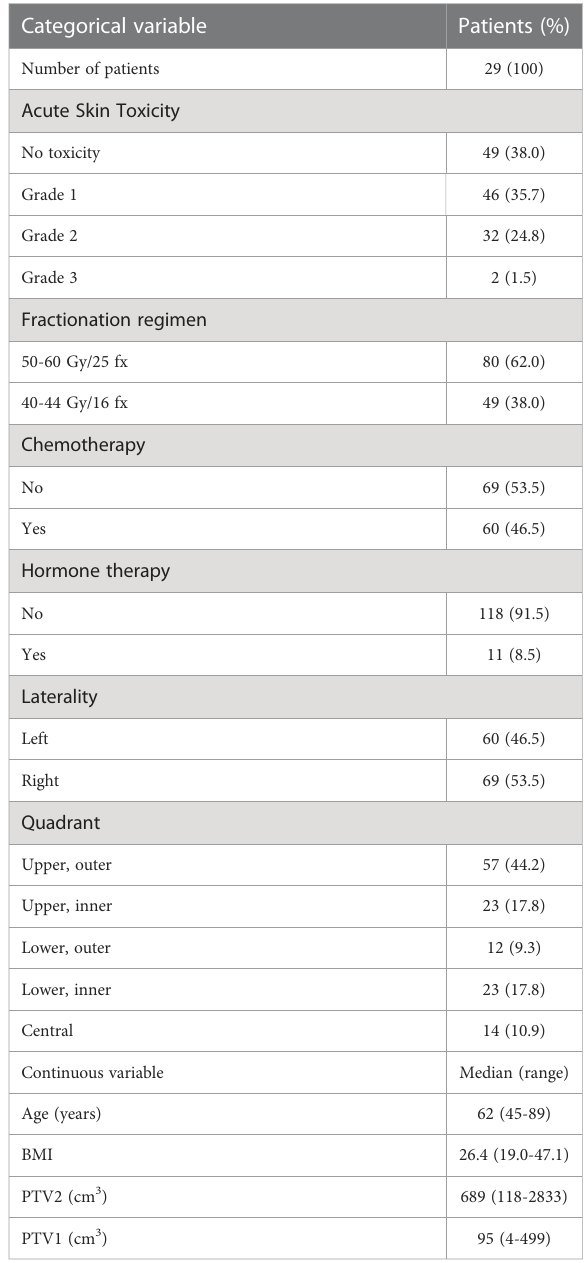
TABLE 1 Patient